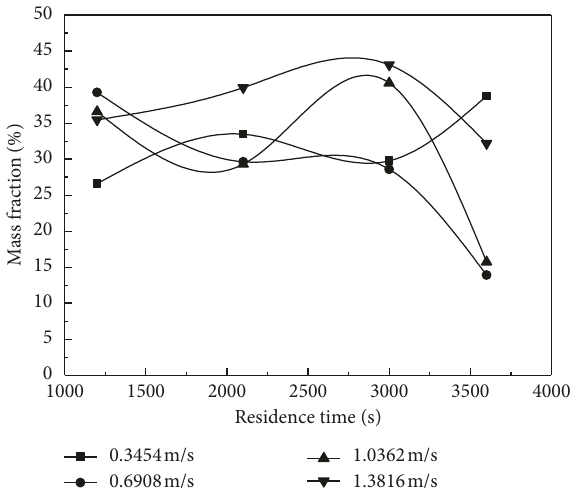
Figure 9: The influence of circulation flow rates on mass fraction of crystal of size larger than 0.350mm for different residence